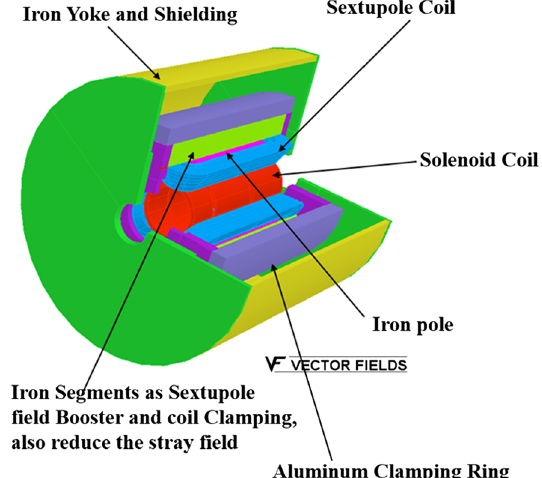
FIG. 7. SECRAL magnet structure and superconducting coil configuration.